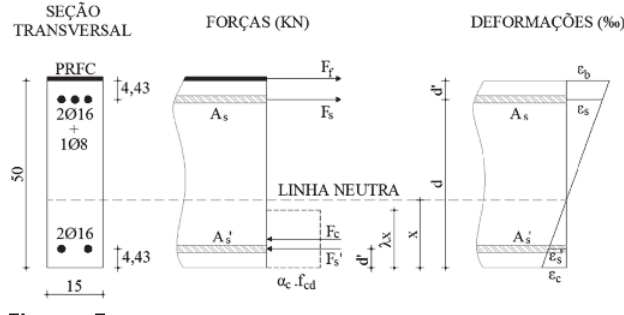
Figura 5. Observa-se que, neste caso, as armaduras tracionadas